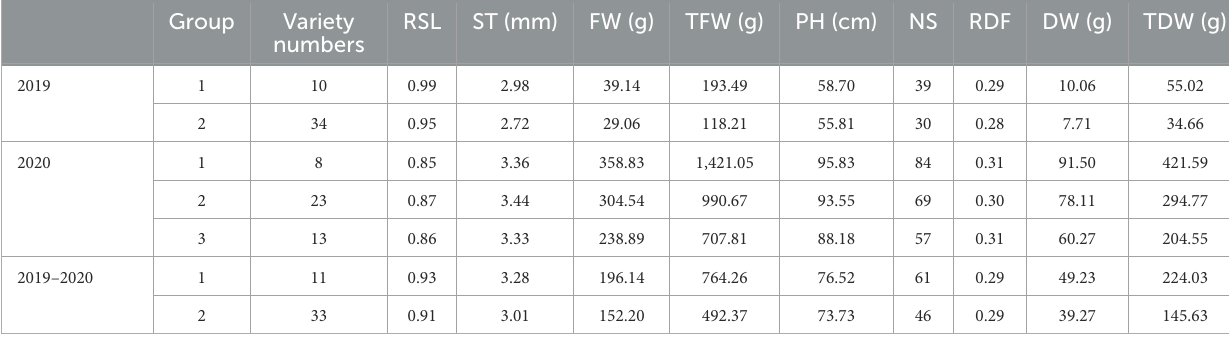
TABLE 7 Cluster analysis of grouping information for 44 varieties of alfalfa.